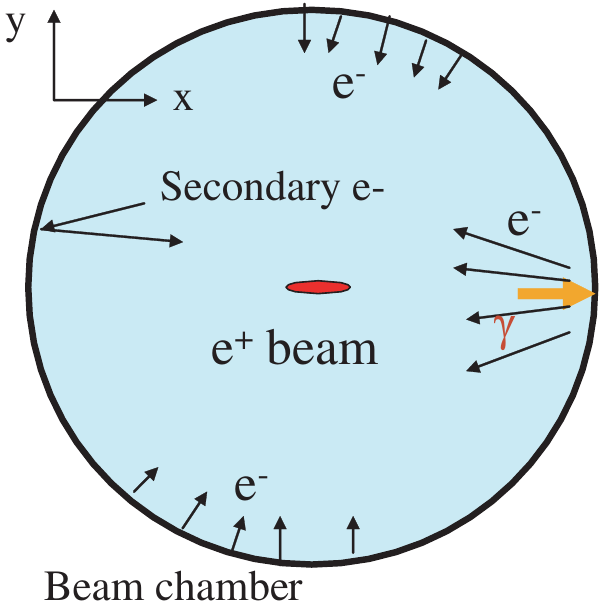
FIG. 1. (Color) Schematic view of simulation of electron cloud buildup. A large part of electrons is produced at a position illuminated by synchrotron radiation, while considerable part are also produced uniformly on the chamber surface due to reflected